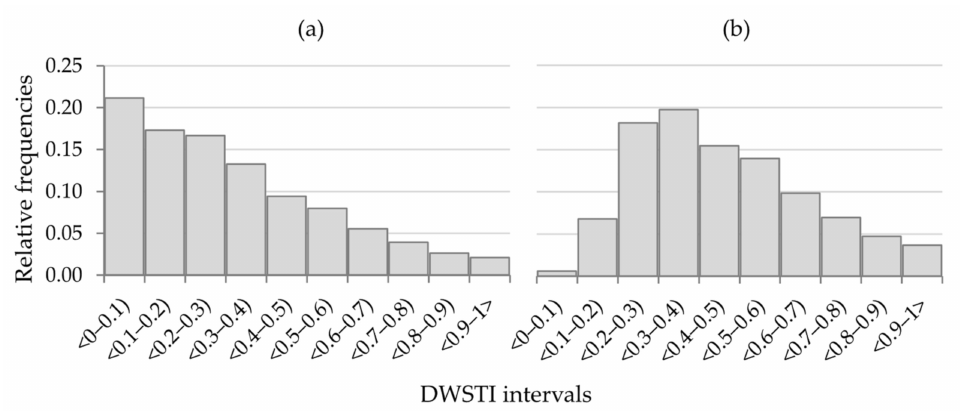
Figure 5. Overview of relative frequencies according to DWSTI: ( a ) completely dataset of municipali- ties (n = 2110; average = 0.310; median = 0.263); ( b ) selected dataset of municipalities that report at least partial issues with drinking water (n = 1189; average = 0.456; median =